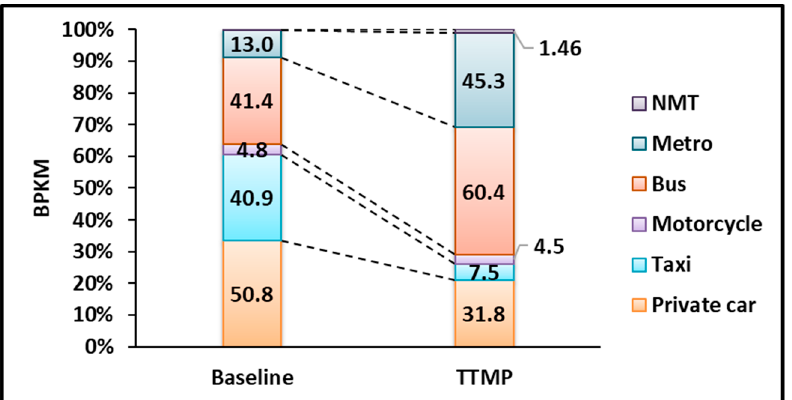
Figure 6. Comparison of transport mode shares between the baseline scenario and the TTMP in 2030.